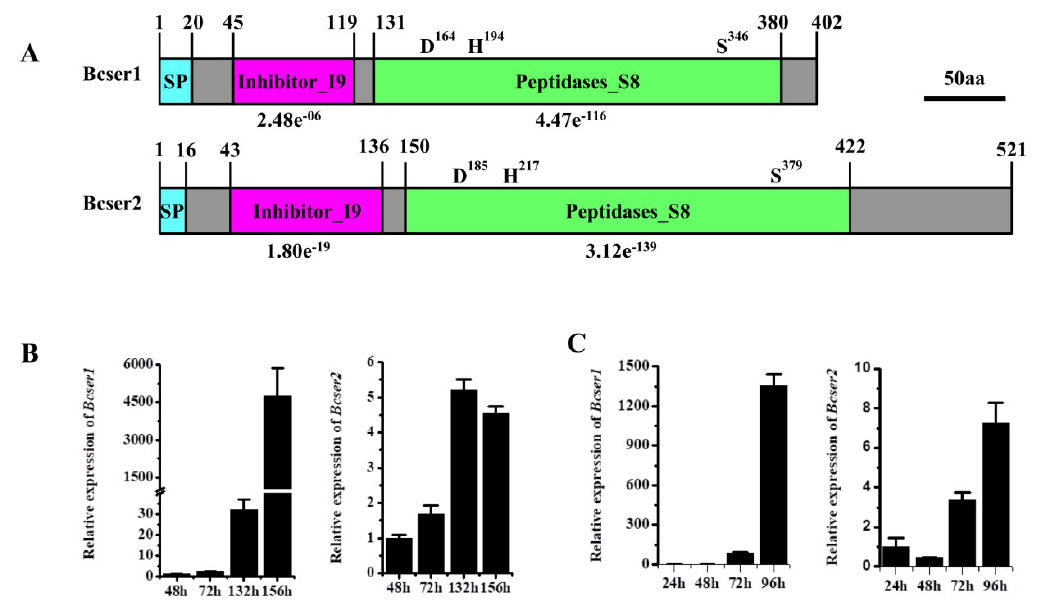
Figure 1. Analysis of the subtilisin-like proteins Bcser1 and Bcser2 . ( A ) Analysis of putative conserved domains encoded by Bcser1 and Bcser2 . ( B ) Relative levels of transcript accumulation of Bcser1 and Bcser2 were determined by qRT-PCR when cultivated on PDA medium at 20 °C. The relative levels of transcripts were calculated using the comparative Ct method. The levels of BcActin transcript of B. cinerea were used to normalize the expression levels. Values are the means of three independent trials. Bars indicate ±SE. ( C ) Relative levels of transcript accumulation of Bcser1 and Bcser2 were determined by qRT-PCR in inoculated Arabidopsis plants at 20 °C. The levels of BcActin transcript of B. cinerea were used to normalize the expression levels.